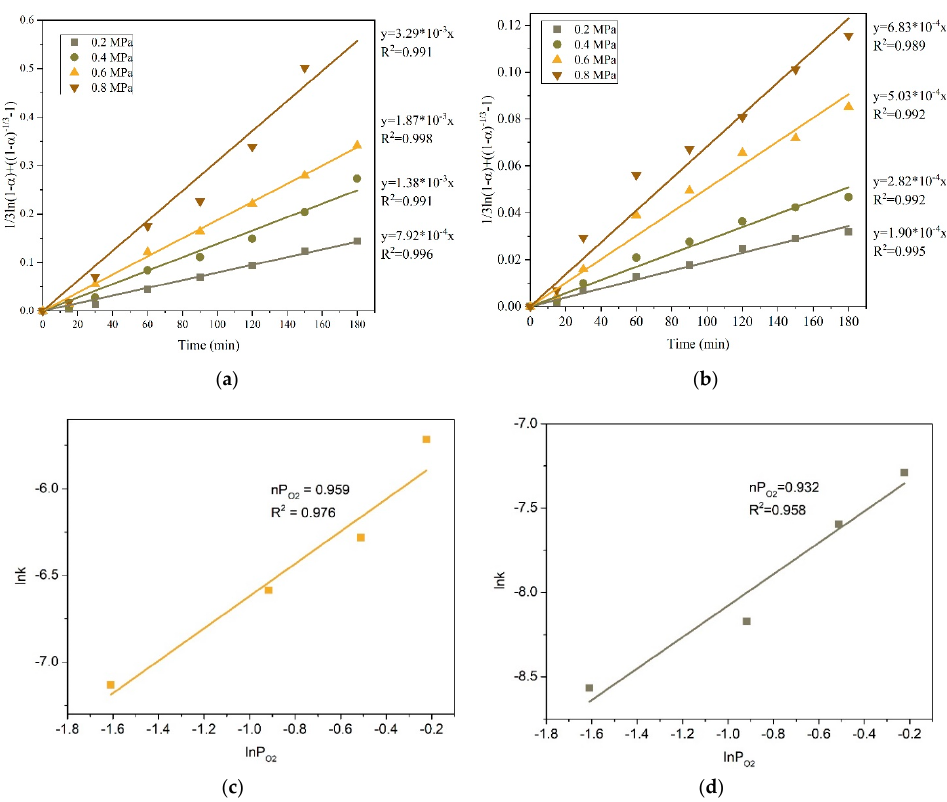
Figure 11. Dependence of 1/3ln(1 − α )+((1 − α ) − 1/3 − 1) on oxygen pressure for Cu ( a ) and Ag ( b ) recovery into solution, and dependence of lnk c on lnP o2 to determine the oxygen order for Cu ( c ) and Ag ( d